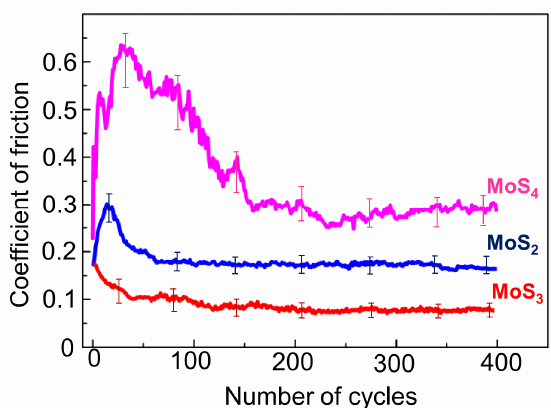
Figure 5. Characteristic evolution of the friction coefficient as a function of the cycle number (for MoS x coatings with different numbers of S atoms). Pin-on-disk tribometer testing was conducted at −100 °C in an argon–air mixture (relative humidity RH ~ 9%). The vertical lines show the range of deviation of the friction coefficient during three tracks of tribological testing on the same sample.